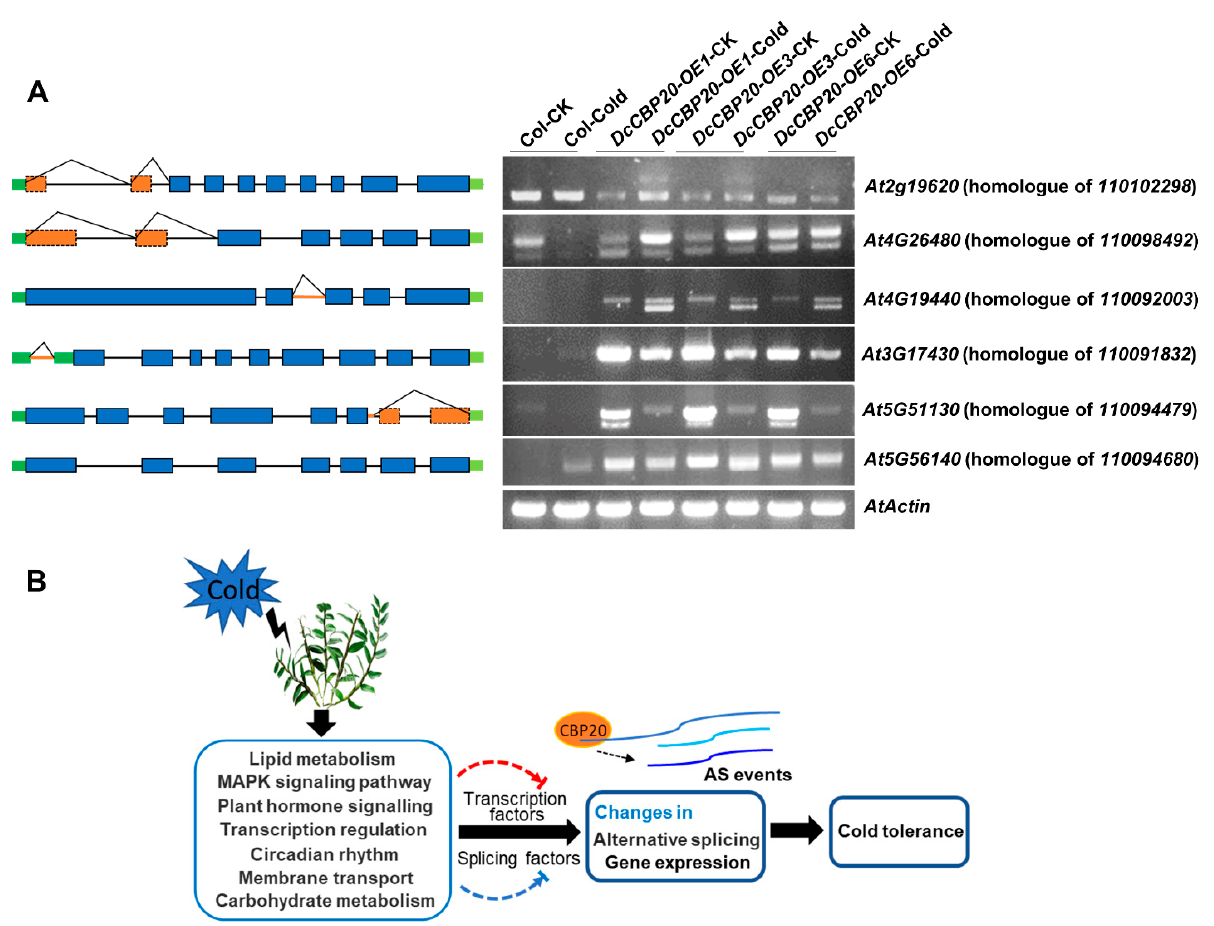
Figure 9. Function of CBP20 homologous gene of D. catenatum in response to cold. ( A ) The splicing isoforms of the PCR products using specific primers in cDNA of DcCBP20 transgenic Arabidopsis detected by RT–PCR. The wild type and DcCBP20 transgenic Arabidopsis were treated with or without 4 °C for 12 h, three independent transgenic lines of DcCBP20-OE were used for RT-PCR analysis. ( B ) A model of the cold signaling pathway in D. catenatum . Under cold stress, differentially expressed genes responding to cold stress in D. catenatum by RNA-Seq were mainly related to lipid